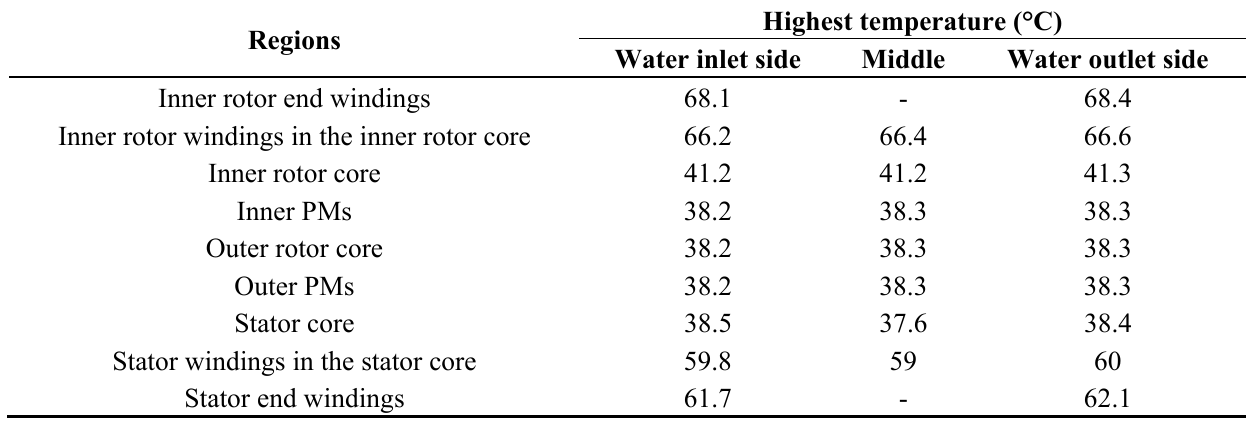
Table 11. Highest temperature of different parts in the CS-PMSM.